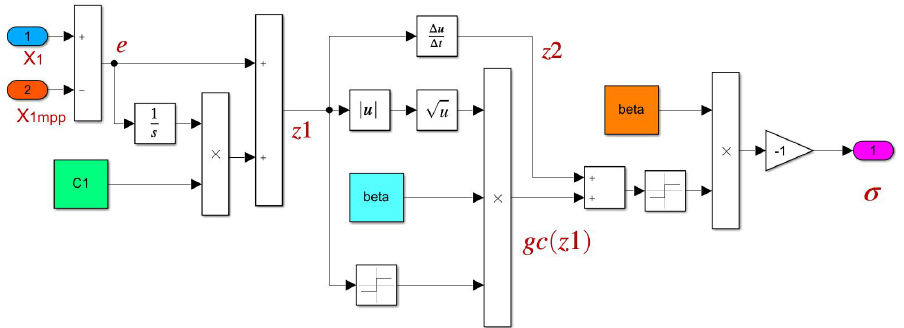
Figure 9. Synoptic diagram of HO-PCL algorithm.